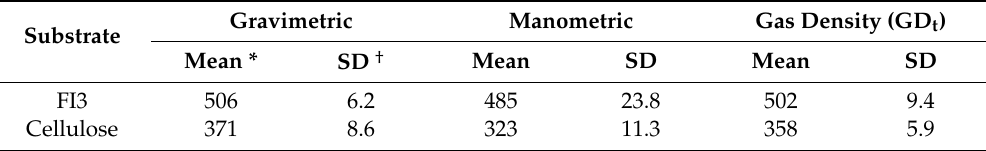
Table 4. Gas density, gravimetric, and manometric estimates of BMP (mL g − 1 ) for two substrates from Experiment 2. The duration was 27 days for all bottles, and n = 3 bottles per